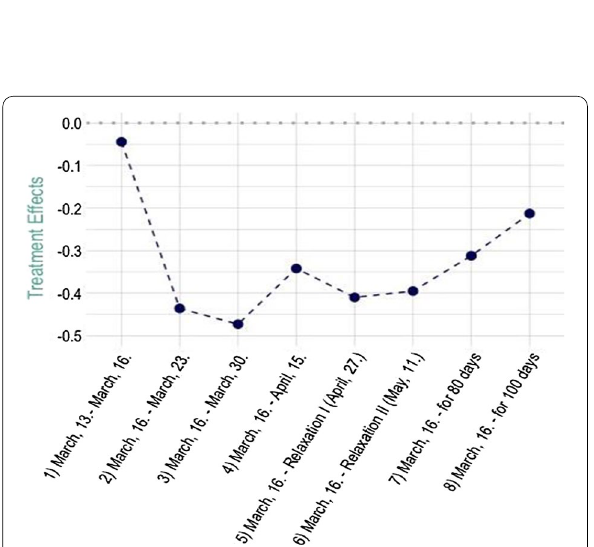
Fig. 6 Shutdown 1 effects for different time periods. Treatment effects from separate regressions using different definitions, i.e., time spans of the treatment variable. Since (canton by occupation clustered) standard errors are very small (< 0.006) they are omitted in this